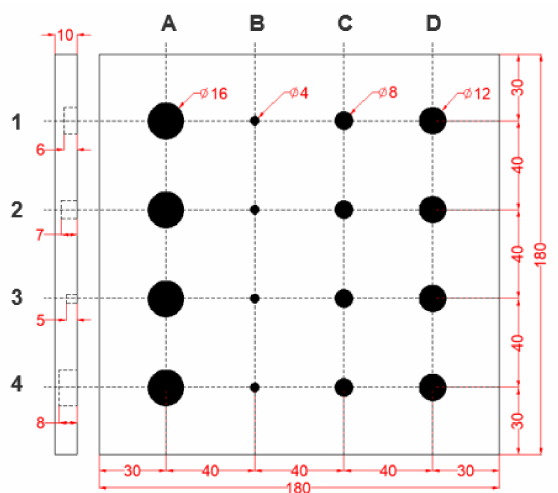
Figure 2. Schematic illustration of the STS304 plate providing depth and diameter information of each